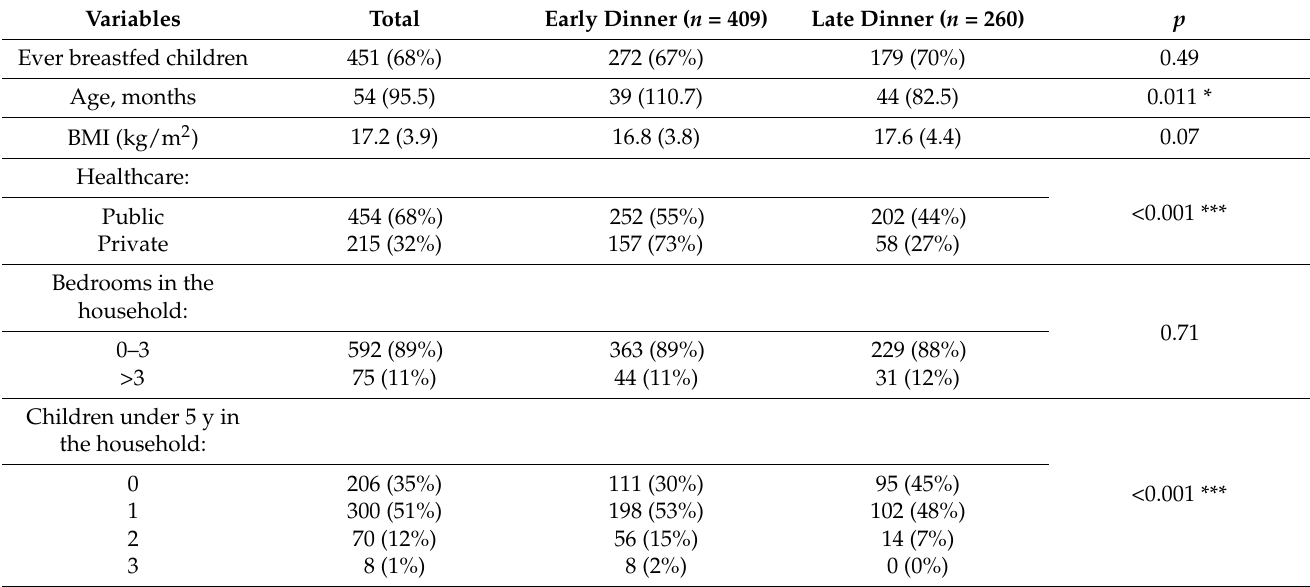
Table 2. Baseline characteristics of total, early dinner eaters and late dinner eaters.